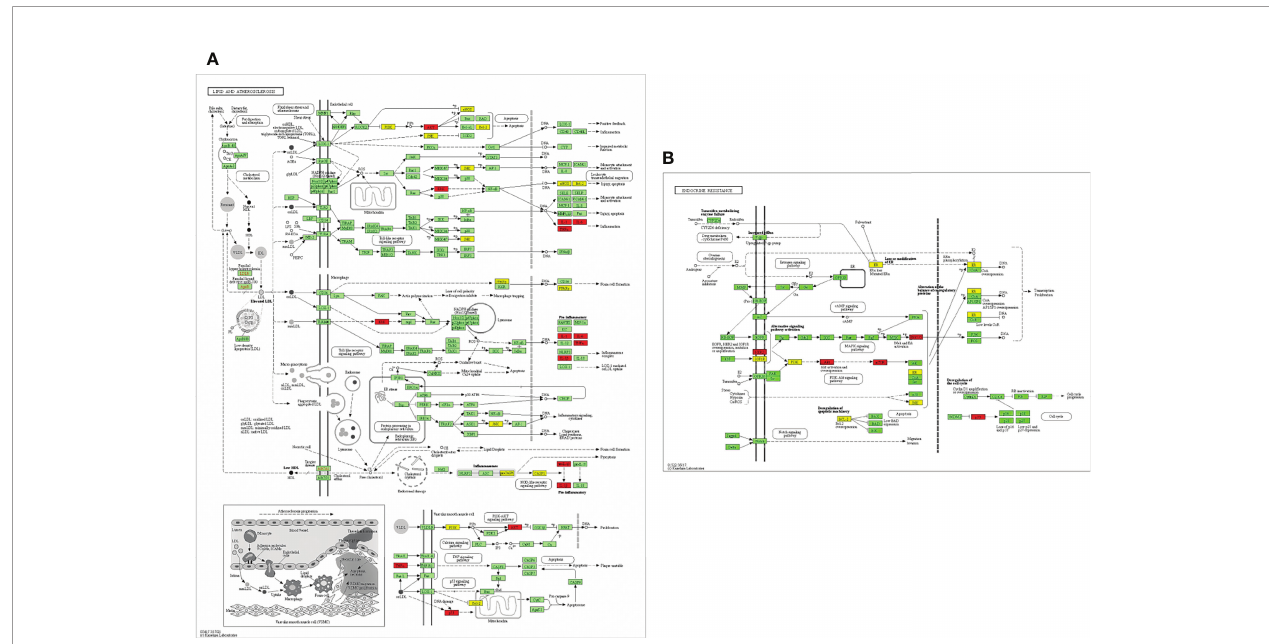
FIGURE 7 | Distribution of potential targets on vital pathways: The nodes in red represent the hub genes; nodes in yellow represent common 33 target genes and nodes in green represents the other targets of pathways [ (A) Lipid and atherosclerosis and (B) endocrine resistance].